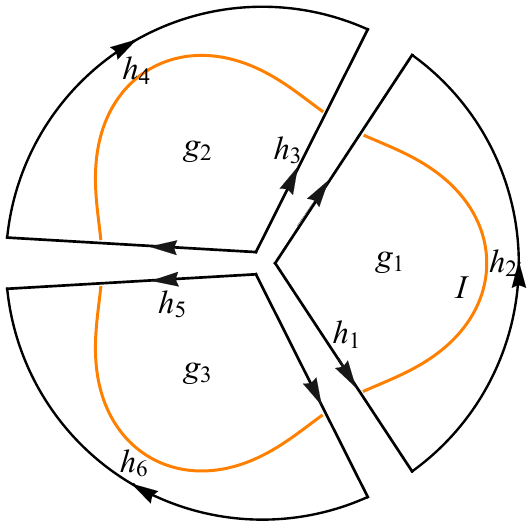
Figure 3 . Cartoon showing an example of gluing of three disk patches whose overall partition function is given by the gluing rules in (3.9). Each segment has an associated group element h a and each patch has an associated holonomy g i . In the case pictured above: g 1 = h 1 h 2 h (cid:0) 1 and g 3 = h 5 h 6 h (cid:0) 1 . We take all edges to be oriented in the counter-clockwise 1